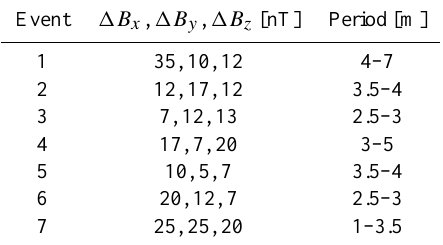
Table 9. Change in magnetic field components taken at the Cluster location for each event and the period of the oscillations.